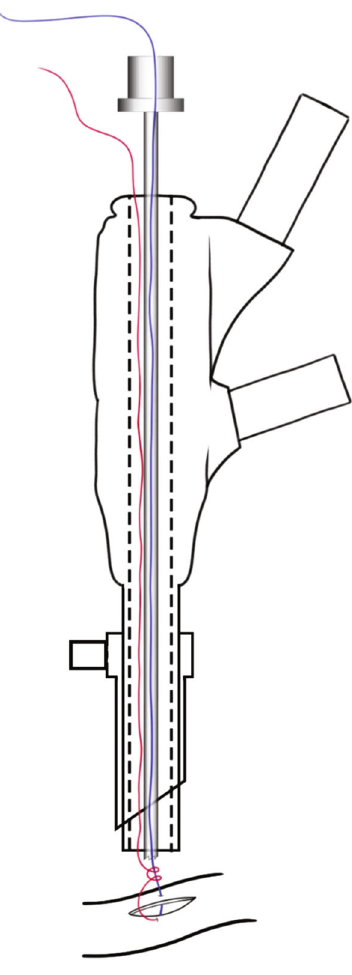
Figure 1: Schematic of the sliding knot using the endoscopic curette. Both threads pass through the working channel of the endoscope. After removing the needle, one of the threads (blue) passes through the endoscopic curette to move the sliding knot to the edge of the